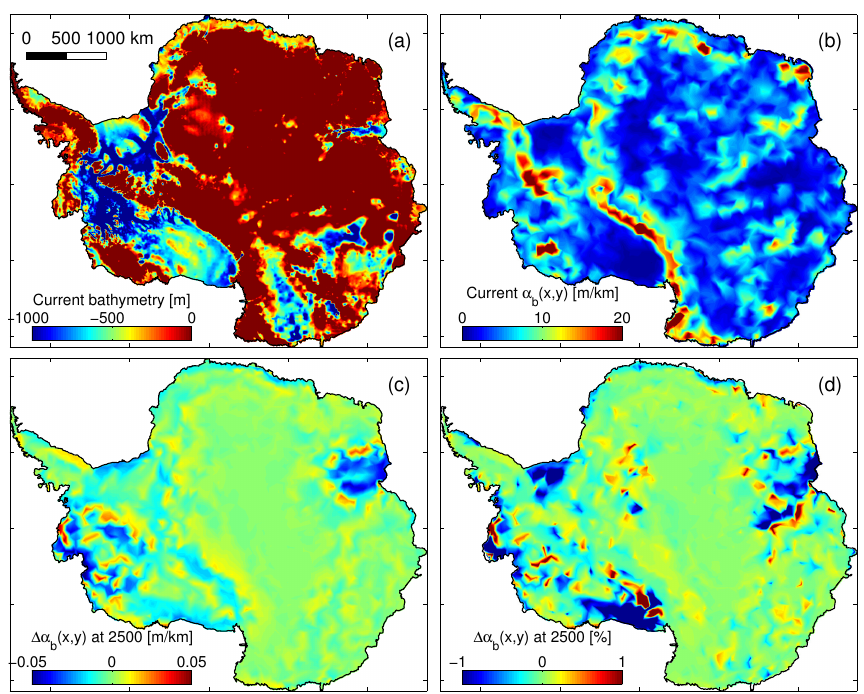
Figure 5. Estimated change in Antarctic bed slope in the future. Present-day (a) bathymetry and (b) bed slope, α b (x,y) , of Antarctica. To facilitate discussions, only data in the range [− 1000 , 0 ] m are shown in Fig. 5a. (c–d) Model-average change in bed slope, 1α b (x,y) , at AD 2500. Negative magnitudes of 1α b (x,y) imply that bedrock will have less steep slopes in the